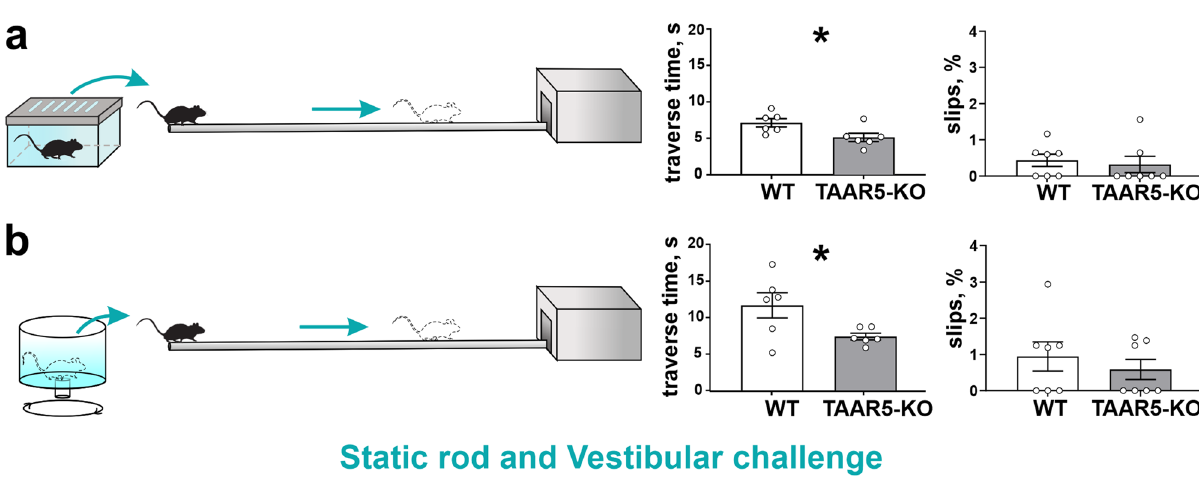
Figure 3. Behavioral testing of motor coordination on the rod, balance, and vestibular control in TAAR5-KO and WT mice. ( a ) Static rod test and traverse time for stepping on it and percentage of slips. ( b ) Vestibular challenge test and traverse time for stepping on it and percentage of slips after 25 s rotation. Values are presented as mean ± SEM, significance level *P <